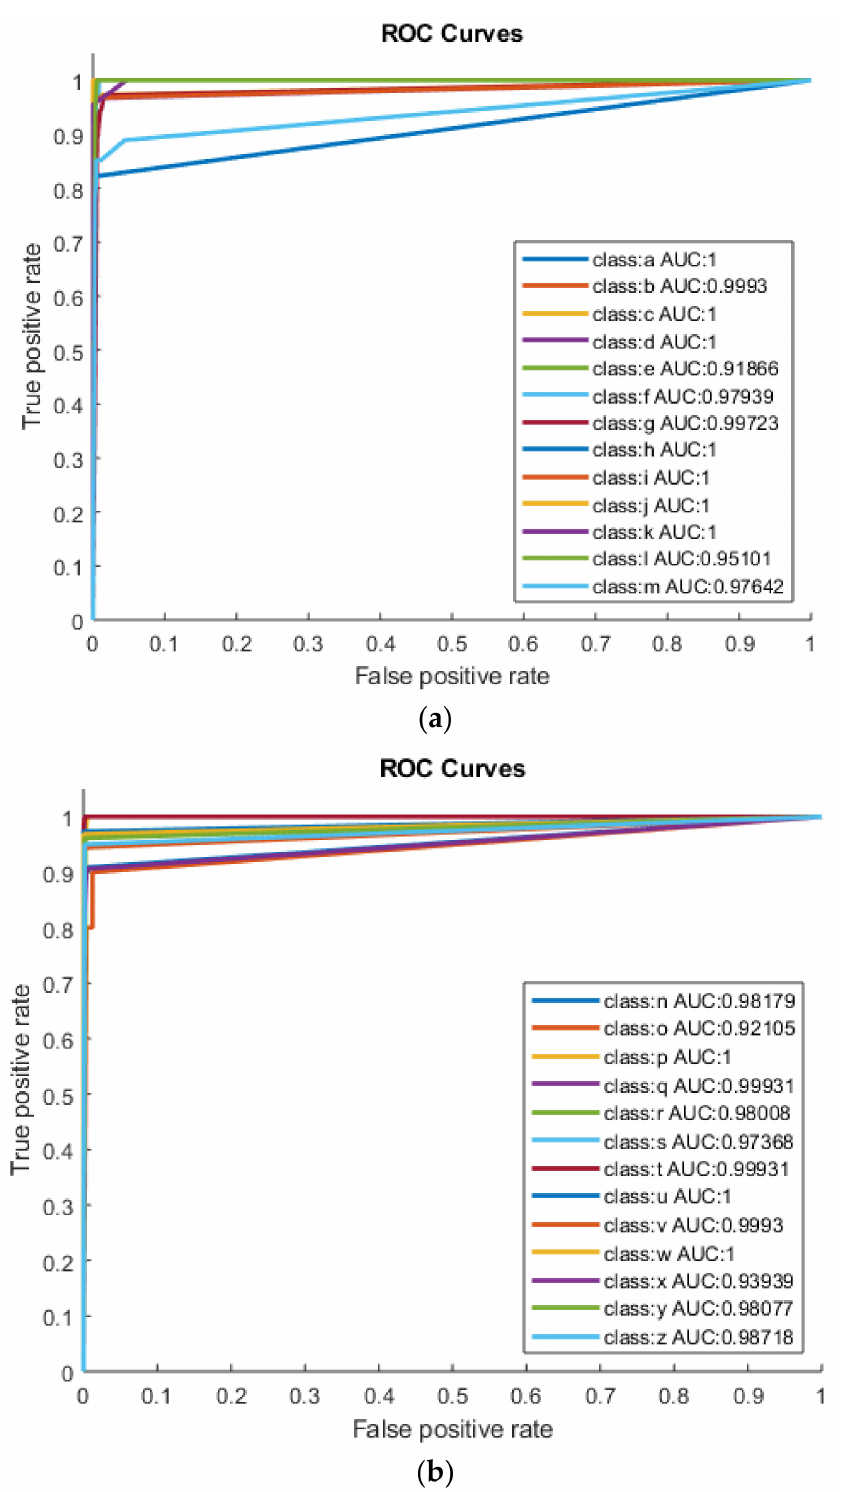
Figure 3. ( a ) Category-1 (a–m) using DT and ( b ) category-2 (n–z) using DT. The highest accuracy achieved for category-1 (a-m) using KNN was for classes a, i, j and k, with TA (100%), TPR (100%), TNR (100%), AUC (1) and F1- Score achieved also equal to 1. As shown in Figure 4a, classes d, l and m have TA (99.87%); TPR (100%, 94.74% and 100%); TNR (99.86%, 100% and 99.87%) and AUC (0.99, 0.97 and 0.99), respectively. As shown in Figure 4b, the classes p, u and y achieve the highest TA of 100%, AUC